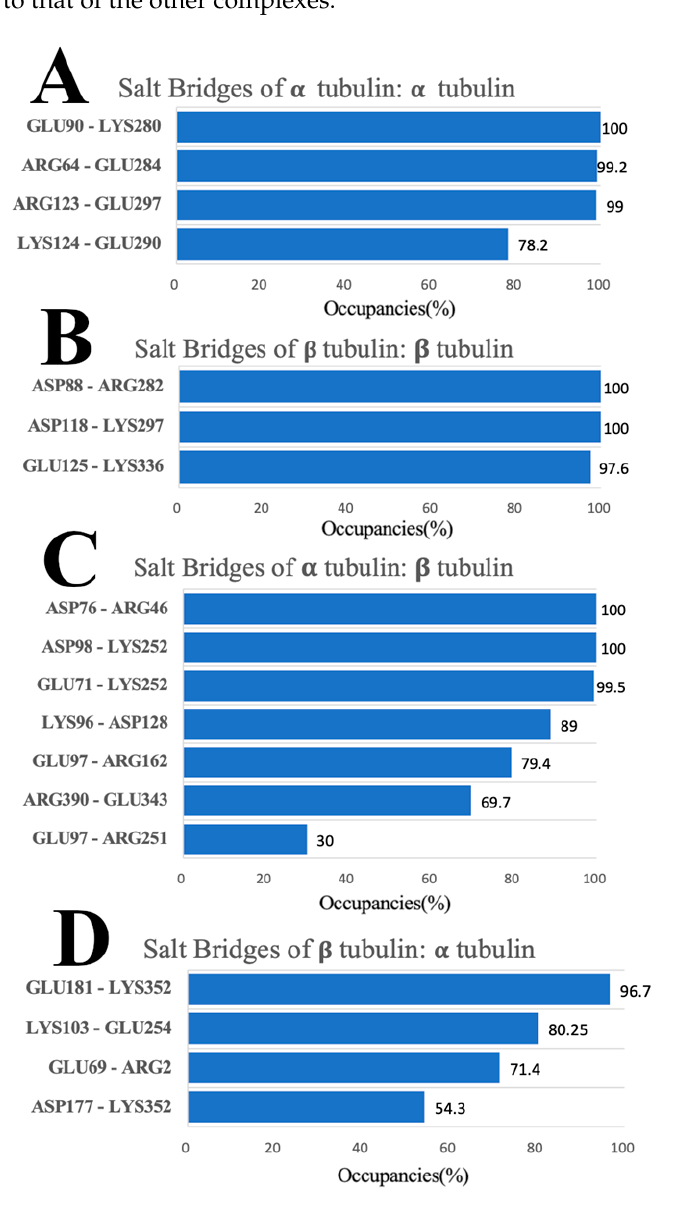
Figure 9. Salt bridges for α / α , β / β , α / β , and β / α tubulin-tubulin complexes with their oc- cupancies. ( A ) α / α tubulin complex. ( B ) β / β tubulin complex. ( C ) α / β tubulin complex. ( D ) β / α tubulin